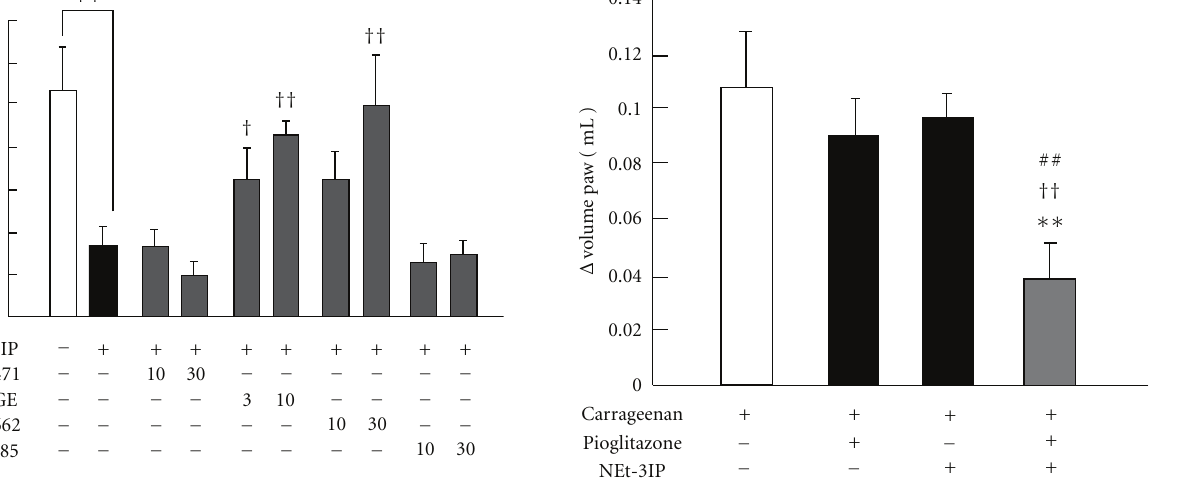
Figure 5: E ff ect of combination of RXR agonist and PPAR γ agonist on carrageenan-induced paw edema . Coadministration of pioglitazone (1mg/kg) and NEt-3IP (1mg/kg), which showed no inhibition each alone, suppressed carrageenan-induce paw edema compared with control group, pioglitazone (1mg/kg) and NEt-3IP (1mg/kg) treated group, respectively. The control group received 0.5% carboxymethylcellulose solution. Each column and vertical bar represents the means ± S.E.M. ( n = 7). ∗∗ : Significantly di ff erent from the control group at P < 0 . 01 (Dunnett’s test). †† : Significantly di ff erent from the pioglitazone treated group at P < 0 . 01 (Dunnett’s test). ## : Significantly di ff erent from the NEt-3IP treated group at P < 0 . 01 (Dunnett’s